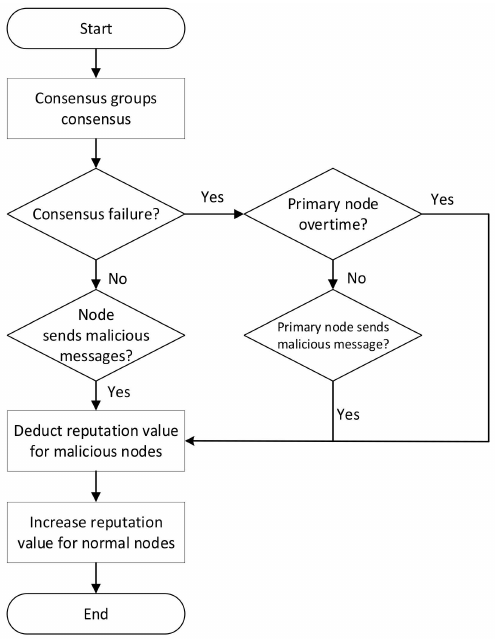
Figure 9. The process of node reputation value update.